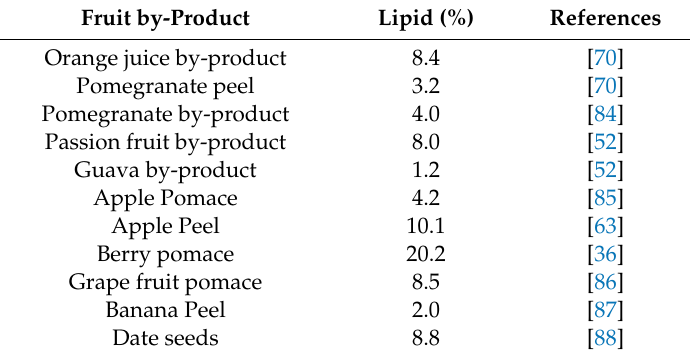
Table 4. Lipid content in some fruit